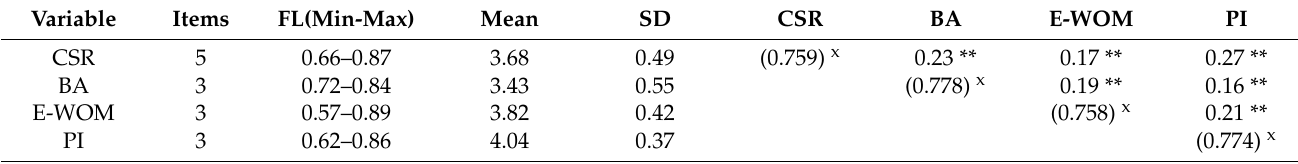
Table 3. Correlations, validities, and